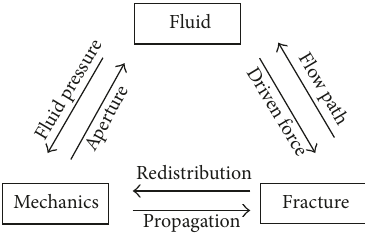
Figure 7: Interaction in H-M-F coupling process.